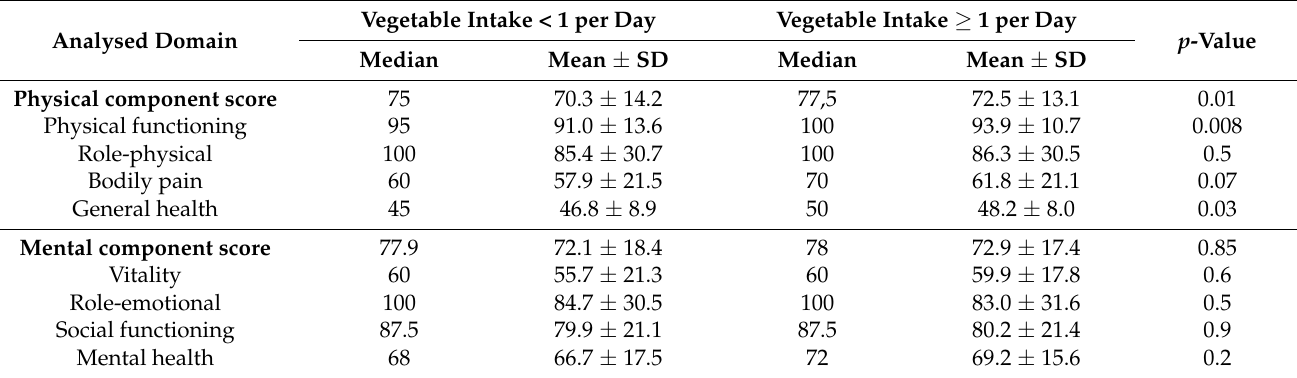
Table 5. Comparison of HQoL according to SF-36 with respect to vegetable intake.